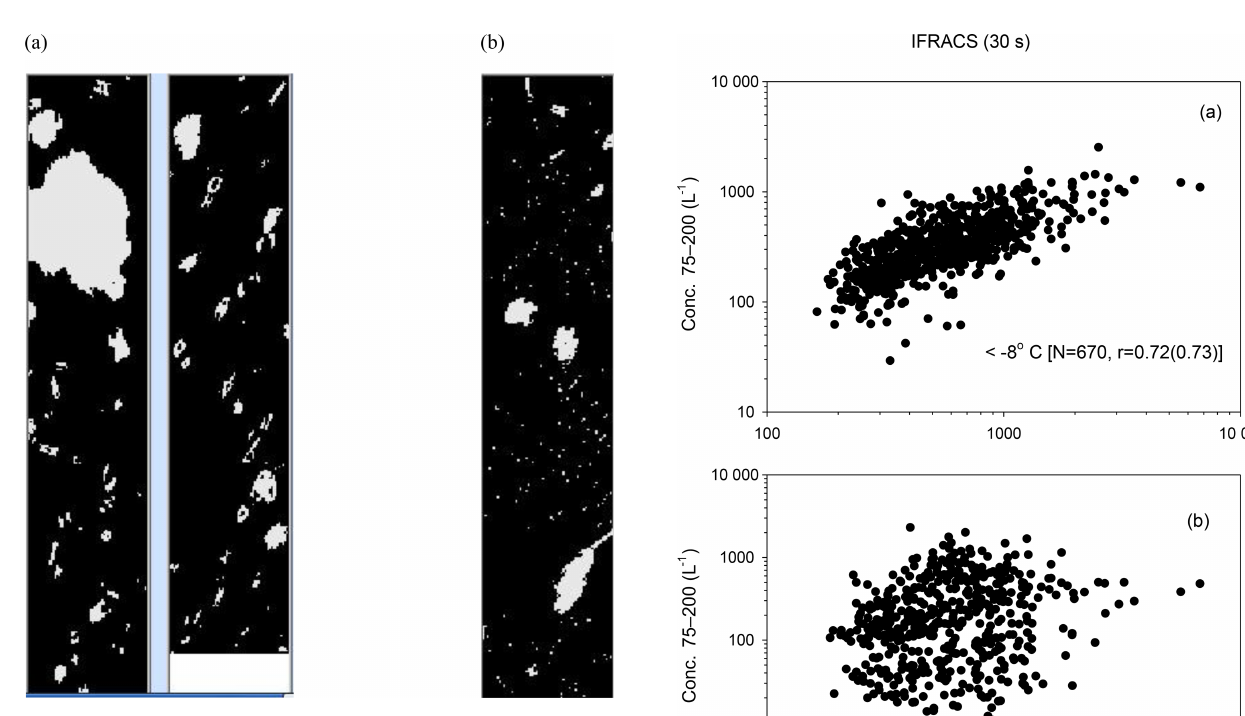
Figure 8. CIP images from 9 February 2014: (a) 13:12:19MST, high-ice and low-LWC, and (b) 12:29:09MST, low-ice and high- LWC periods. The vertical bars contain all of the images sampled in 1s. The width of each bar corresponds to 1600µm. Table 3. Relationships between TAS and small ice crystal concen- Figure 9. Relationships between 30s average concentrations of trations (Conc75-200) during StormVEx and IFRACS. r is the Pear- large cloud droplets (CDNC25-35) and small ice crystals (Conc75- son (Spearman rank) correlation. 200) during IFRACS under cold conditions ( < 8 ◦ C) and warm ( > 8 ◦ C) conditions. The number of observations and the Pearson StormVEx IFRACS (Spearman rank) correlations are